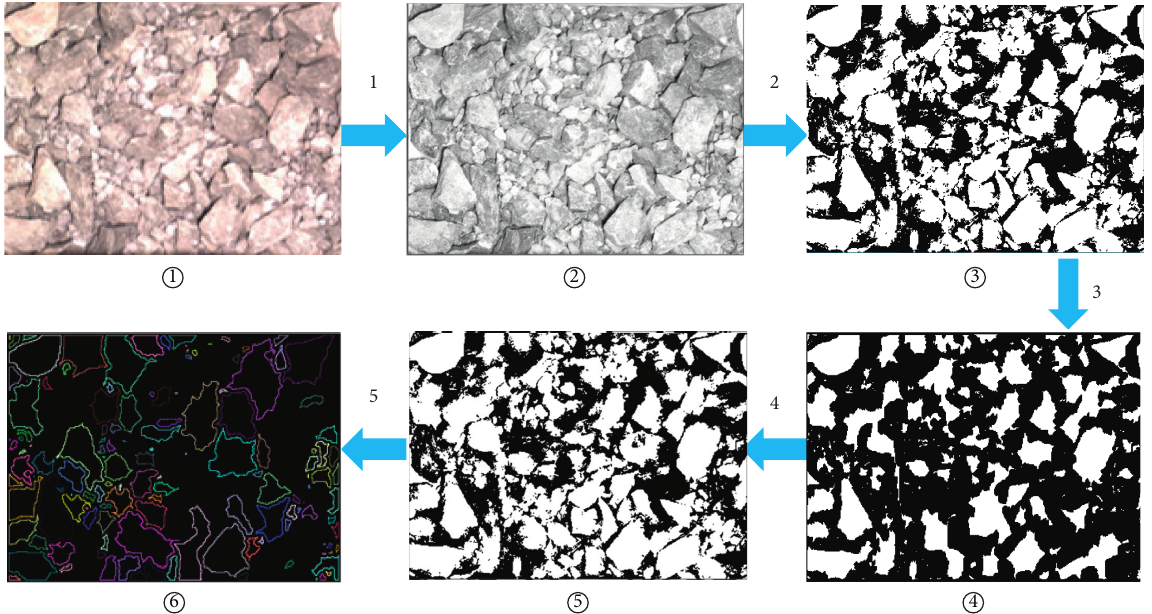
Figure 5: Process of the image recognition algorithm for earth and stone materials (1: image enhancement, 2: thresholding, 3: topological separation, 4: corroding then expanding to solve adhesion, and 5: edge